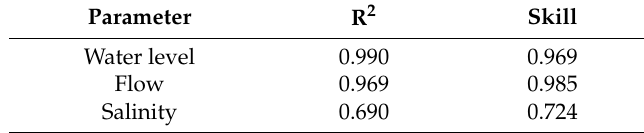
Figure 6. ( A ) Observed salinity; ( B ) predicted salinity; ( C ) predicted-observed salinity in the Cache Slough Complex during the U.S. Geological Survey (USGS) field study on 1 October 2014. Table 2. Model performance metrics averaged across all continuous monitoring